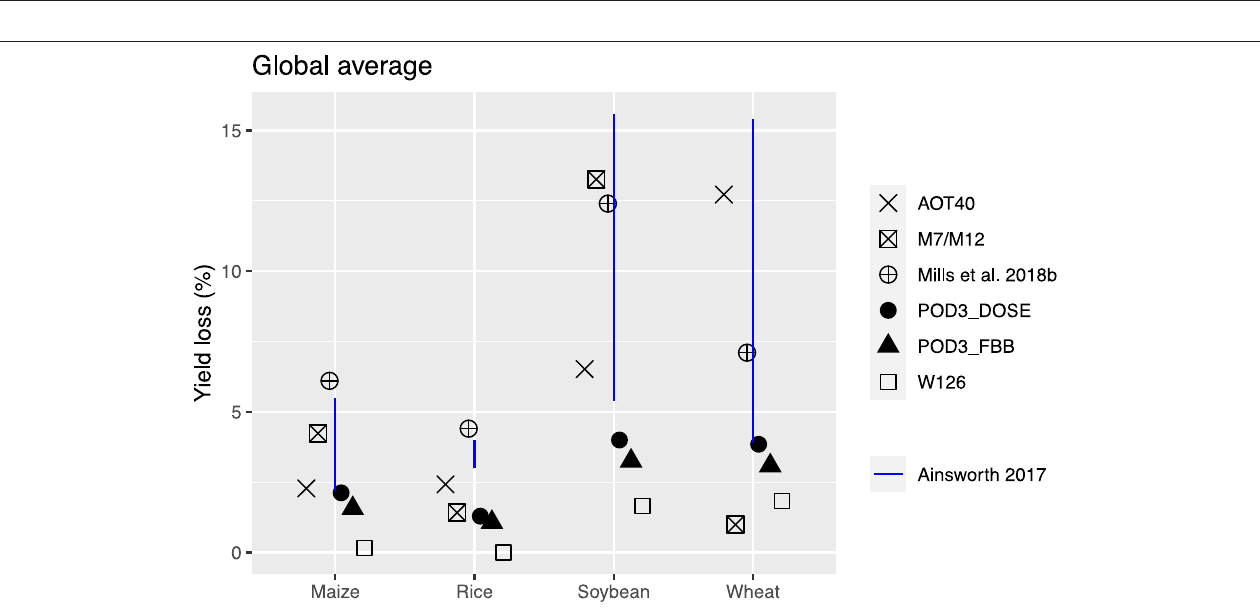
FIGURE 10 | Aggregated global yield loss (%) estimates for four major crops using AOT40, M7/M12, W126, POD 3 -DO 3 SE, and POD 3 -FBB. Shown also are previous findings: Mills et al. (2018b) used flux-based metrics similar to POD 3 -DO 3 SE, while Ainsworth (2017) considered AOT40 and M7/M12.